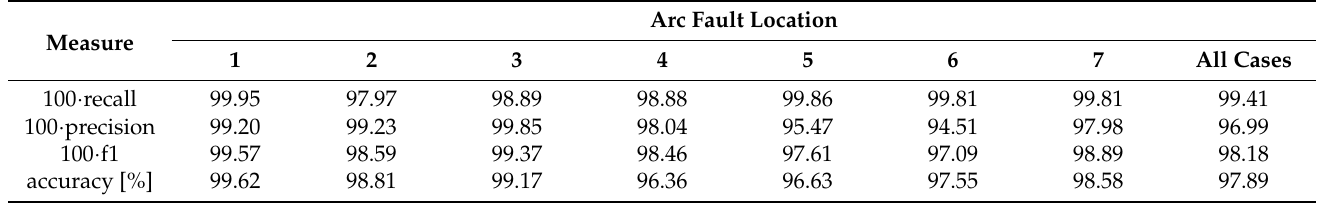
Table 6. Arc fault detection in terms of IEC 62606:2013 standard results considering the location of arc faults for sampling rate 12.5